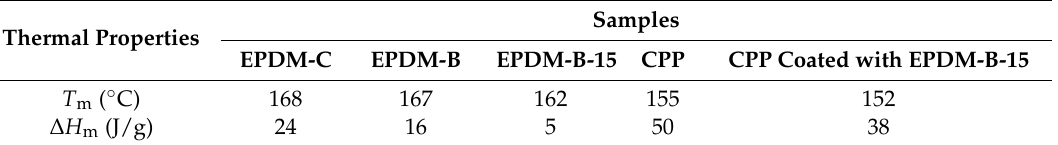
Figure 4. DSC thermograms during heating for ( a ) raw materials and EPDM-B-15 and ( b ) EPDM-B-15, CPP film and CPP coated with EPDM-B-15. Table 1. Results of DSC